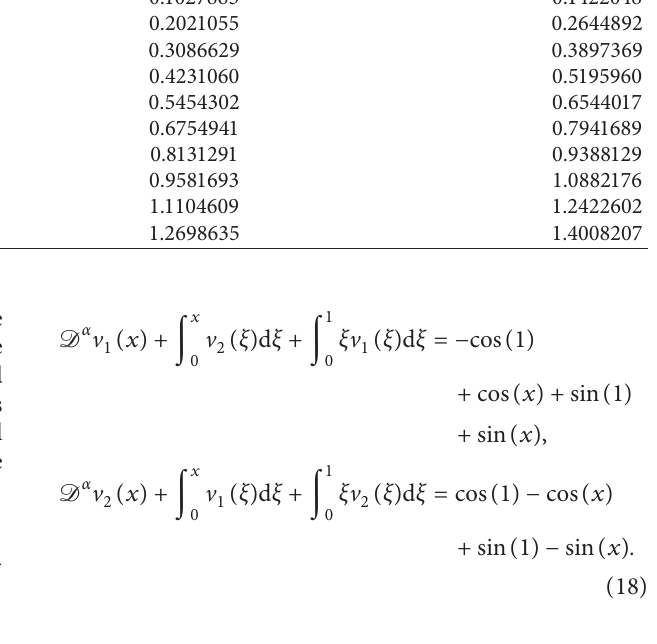
Table 5: Numerical results of exact v